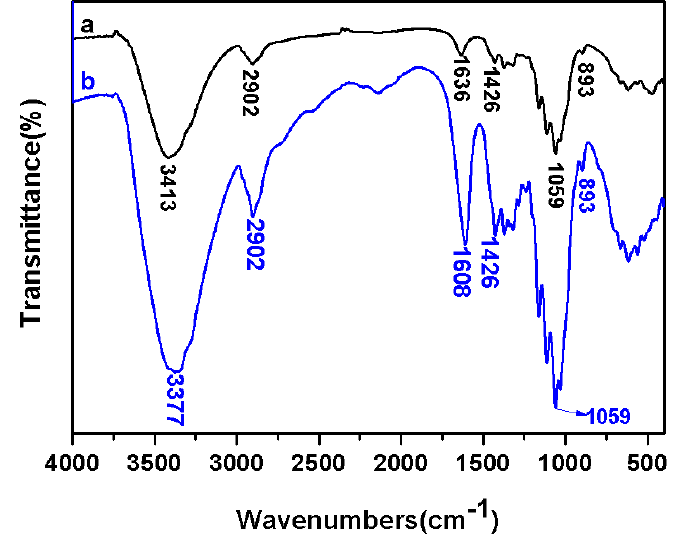
Figure 2. FT-IR spectra of the original cellulose (a) and cellulose-COONa (b).